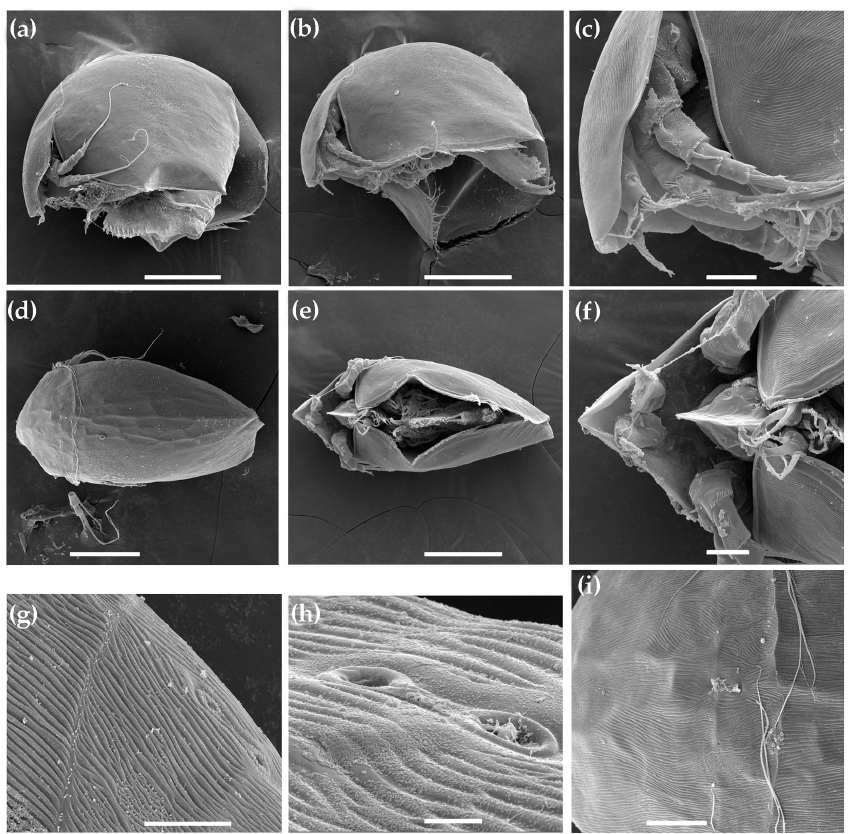
Figure 12. Anthalona mediterranea , adult parthenogenetic females from Wadi Maidaq — Blue Pool, United Arab Emirates. ( a , b ), Female, lateral view; ( c ) head, lateral view; ( d ) female, dorsal view; ( e ) female, ventral view; ( f ) head, ventral view; ( g ), ornamentation of dorsal part of head; ( h ) main head pores; ( i ) lateral and main head pores. Scale bars: 0.1 mm for (a,b,d,e) , 0.02 mm for ( c , f , i ), 0.01 mm for ( g ), 0.002 mm for ( h ).